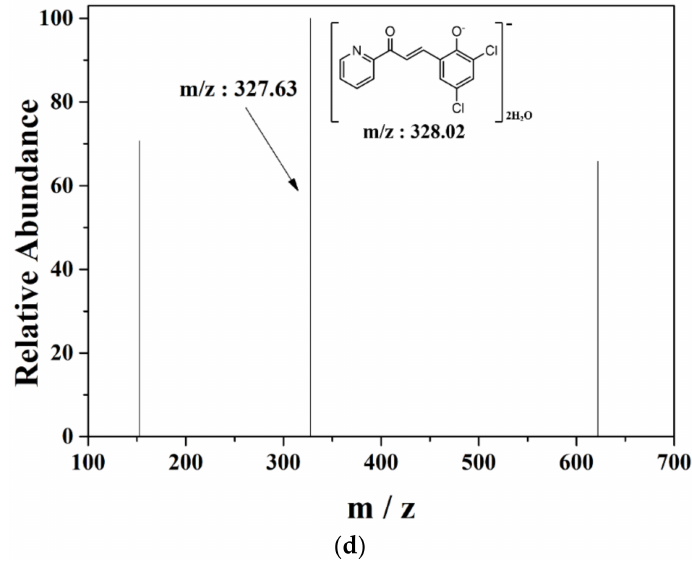
Figure 1. ( a ) Synthesis scheme of DPP . ( b ) 1 H NMR spectrum of DPP . ( c ) 13 C NMR spectrum of DPP . ( d ) Negative-ion mass spectrum of DPP (100 µ M).